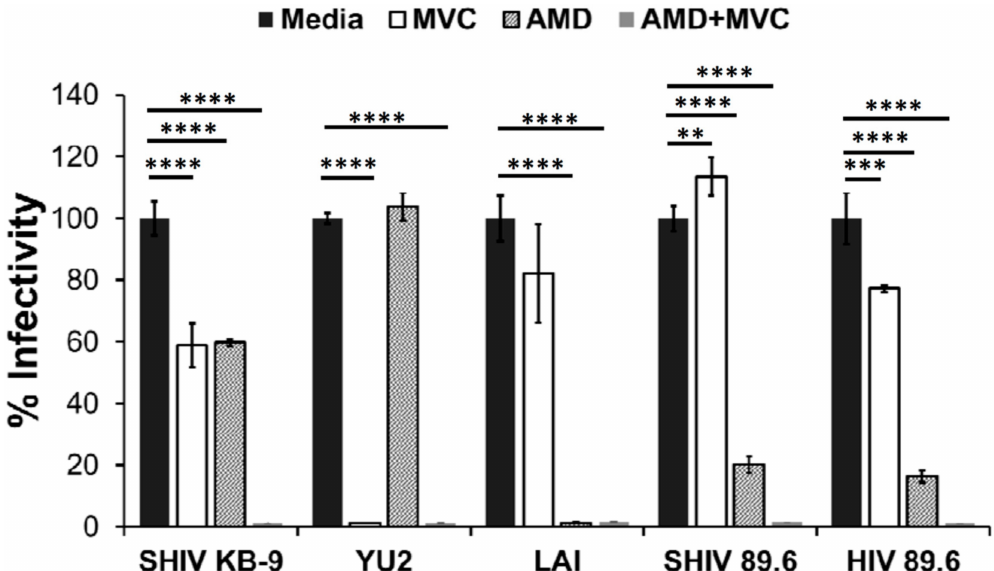
Figure 4. Variable coreceptor usage by SHIV Envs. HIV-1 virions pseudotyped with indicated Envs were used to infect TZM-bl indicator cell line. Pseudotyped virus infections were conducted in the presence of inhibitors Maraviroc (MVC), AMD 3100 (AMD), a combination of both AMD and MVC (AMD + MVC) or no inhibitor (media). Virus infectivity was determined 72 h later by measuring luciferase activity. **** = p ≤ 0.0001; *** = p ≤ 0.001; ** = p ≤ 0.01 as determined by one-way ANOVA followed by Dunnett’s multiple comparison